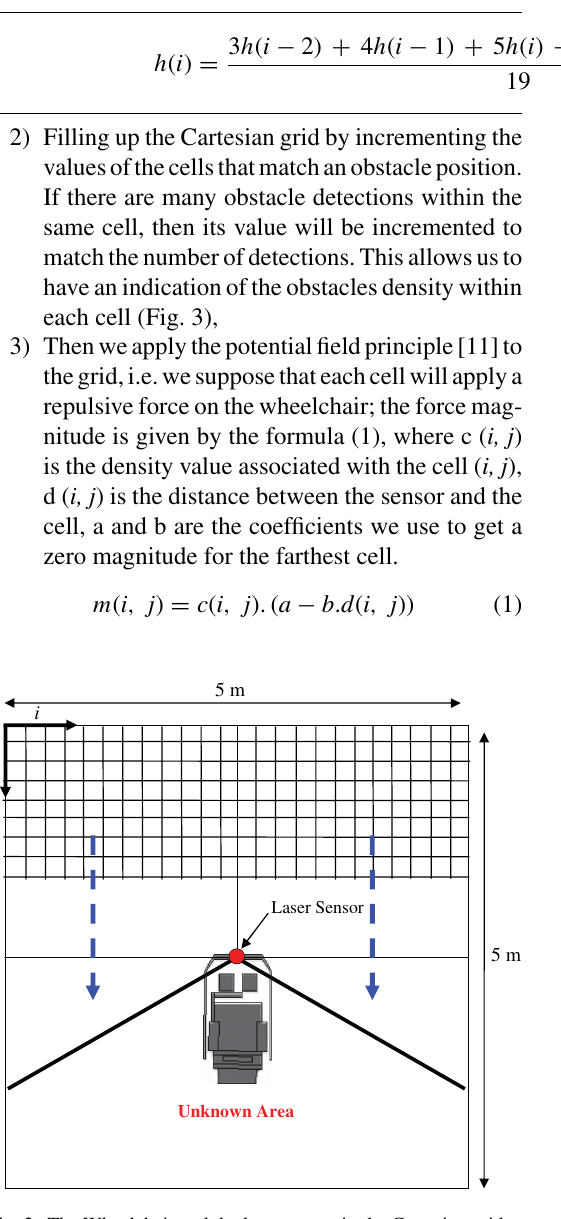
Fig. 2. The Wheelchair and the laser sensor in the Cartesian